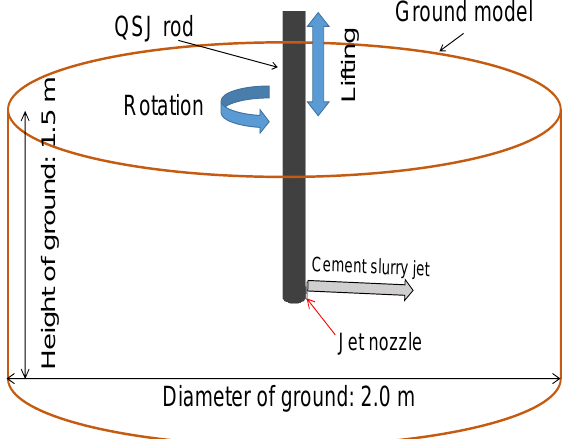
Figure 3. Conceptual jet-grouting method model.